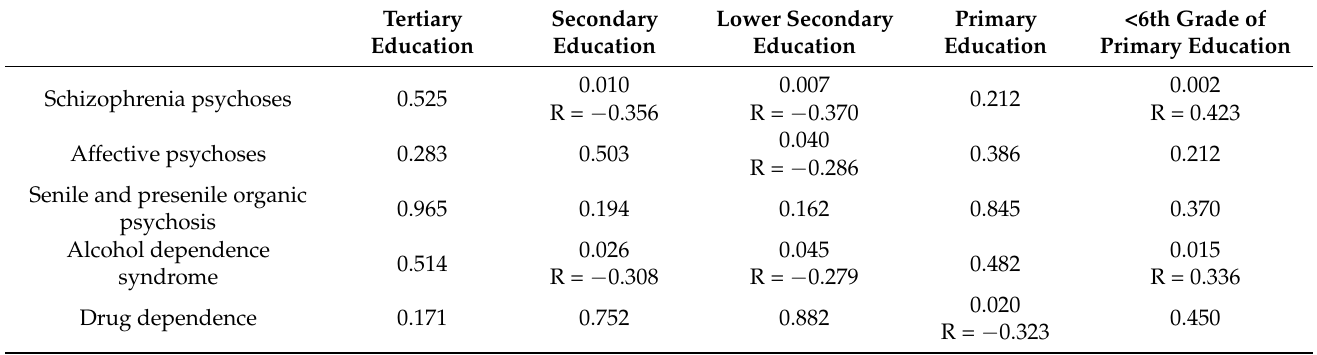
Table 5. Pearson’s correlation between sex- and age-adjusted PHR of mental disorders and education level ( p -value, R: Pearson’s correlation coefficient).